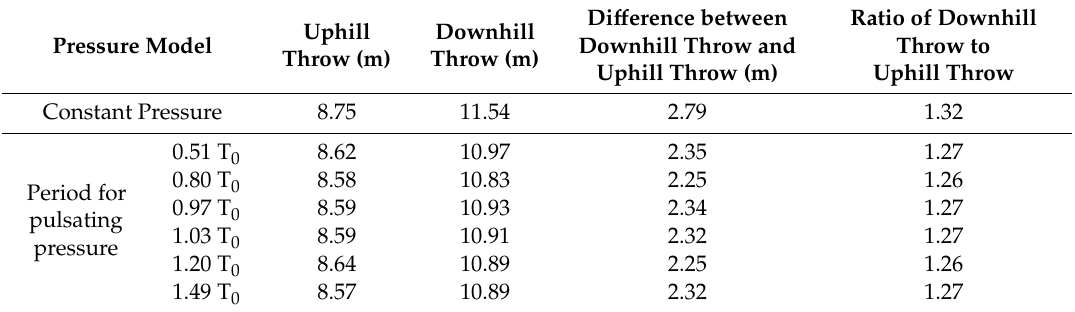
Table 1. Radius of throw at the constant pressure and the pulsating pressure.